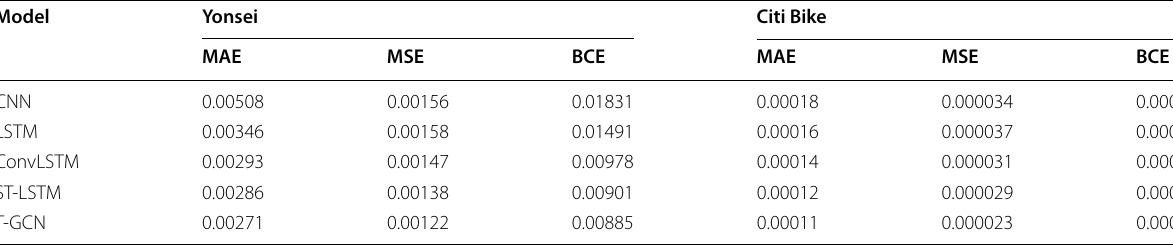
Table 2 Prediction results of deep learning models on Yonsei and Citi Bike datasets